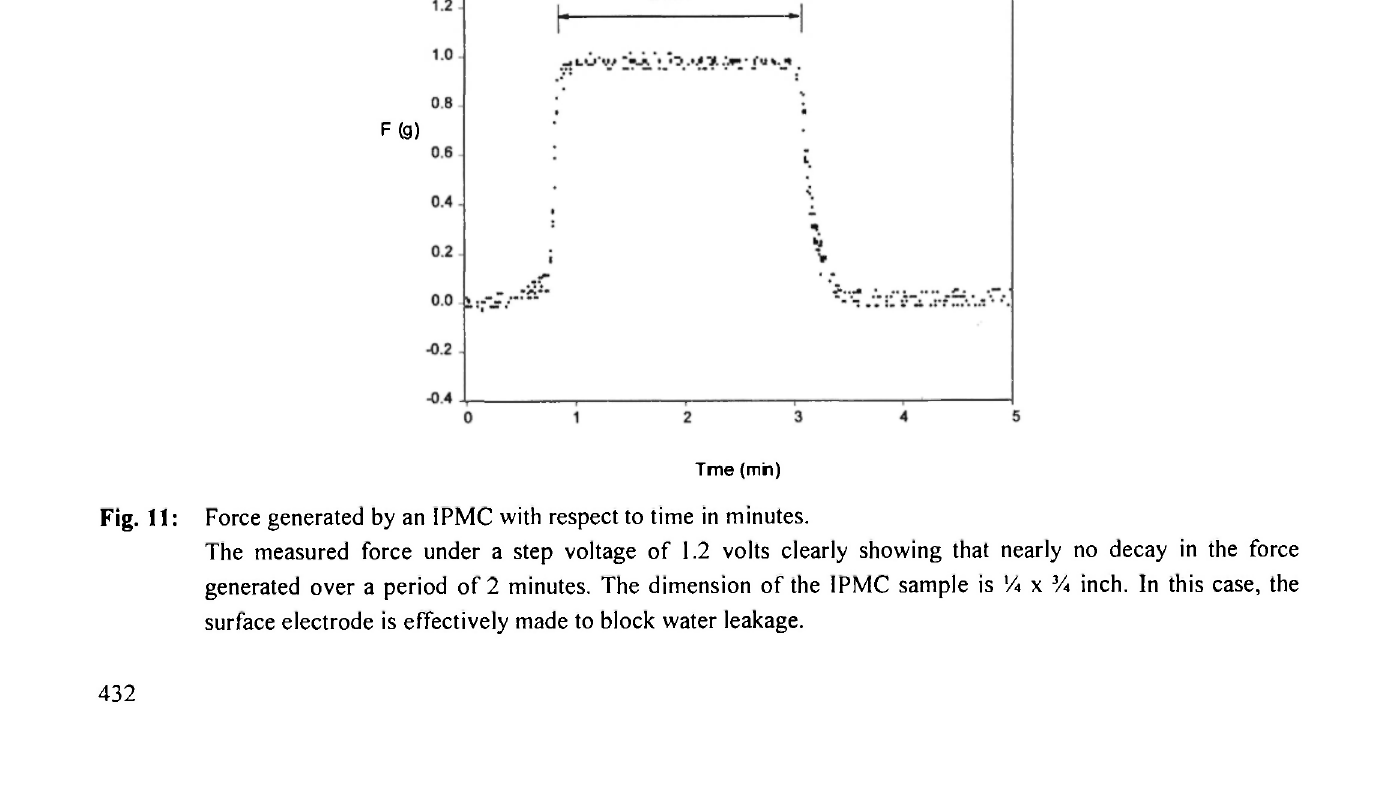
Fig. 10: Force response characteristics of the IPMC. This is based upon Nafion™-! 17.